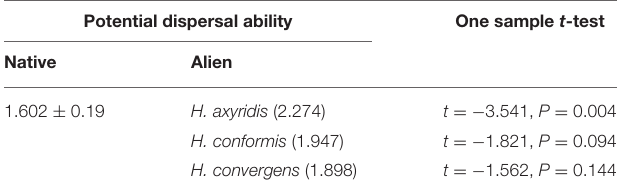
TABLE 4 | Potential dispersal ability (average ± SE; N = 13) of native and alien aphidophagous ladybird species in Europe. Potential dispersal ability